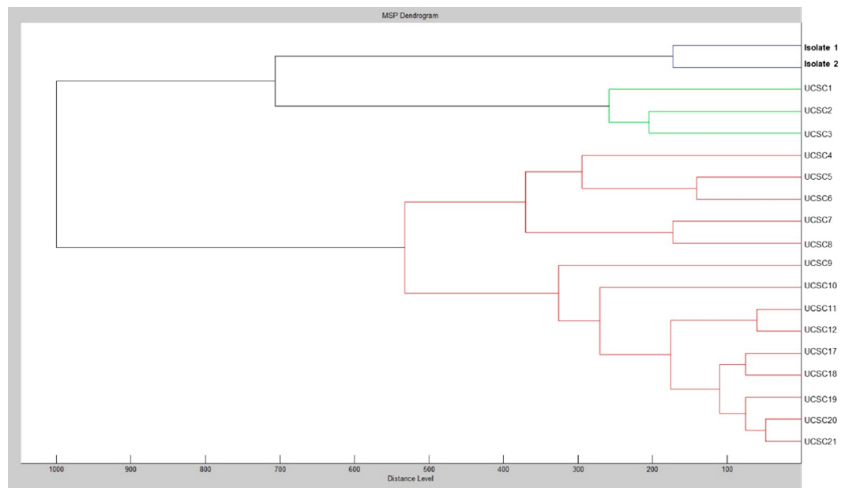
Figure 1. Cluster analysis of matrix-assisted laser desorption/ionization time-of-flight (MALDI-TOF) mass spectra obtained for 19 C. glabrata isolates, including the patients’ isolates 1 and 2. Shown is a dendrogram in which the distance between isolates is indicated as relative units. Zero means complete similarity and 1000 means complete dissimilarity. An arbitrary distance level of 500 was chosen to assess clustering among isolates.